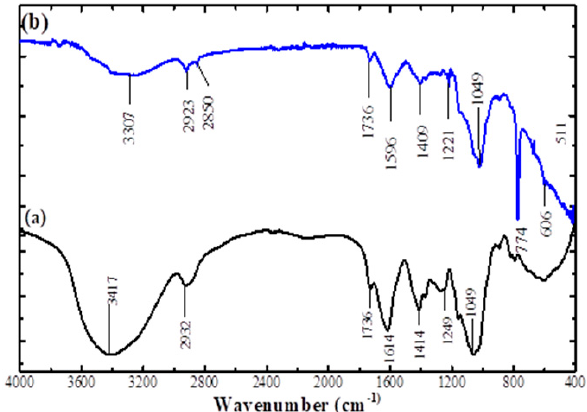
Figure 3. FTIR spectra of ( a ) xanthan gum (XG) ( b ) ZnO@XG